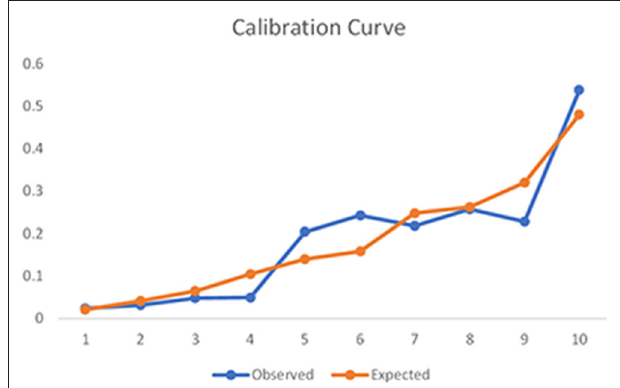
FIGURE 4 | Calibration curve for the model to predict sICH. The calibration curve for the model showing the calibration ability of the model. Hosmer-Lemeshow χ 2 = 6.924, P = 0.549 >